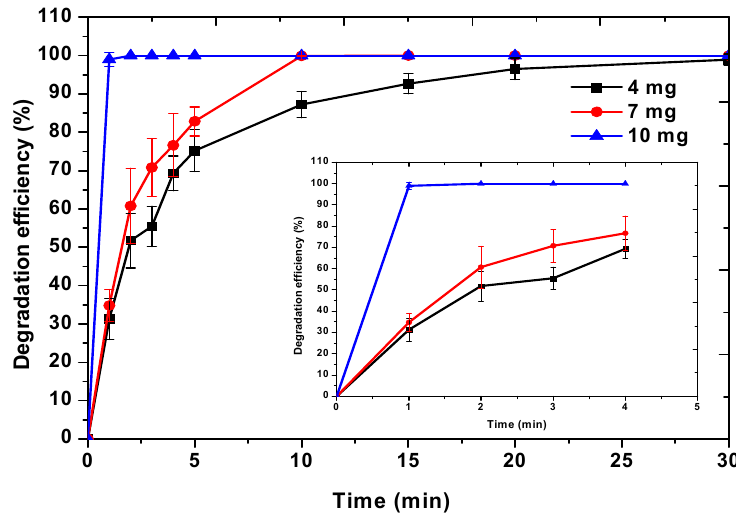
Figure 8. Degradation efficiencies of 10 mg/L methyl orange dye (pH ~ 4.5) by Fe/Cu/Ag 5:1:0.2 nanoparticles with varying nanoparticle dosage at room temperature.